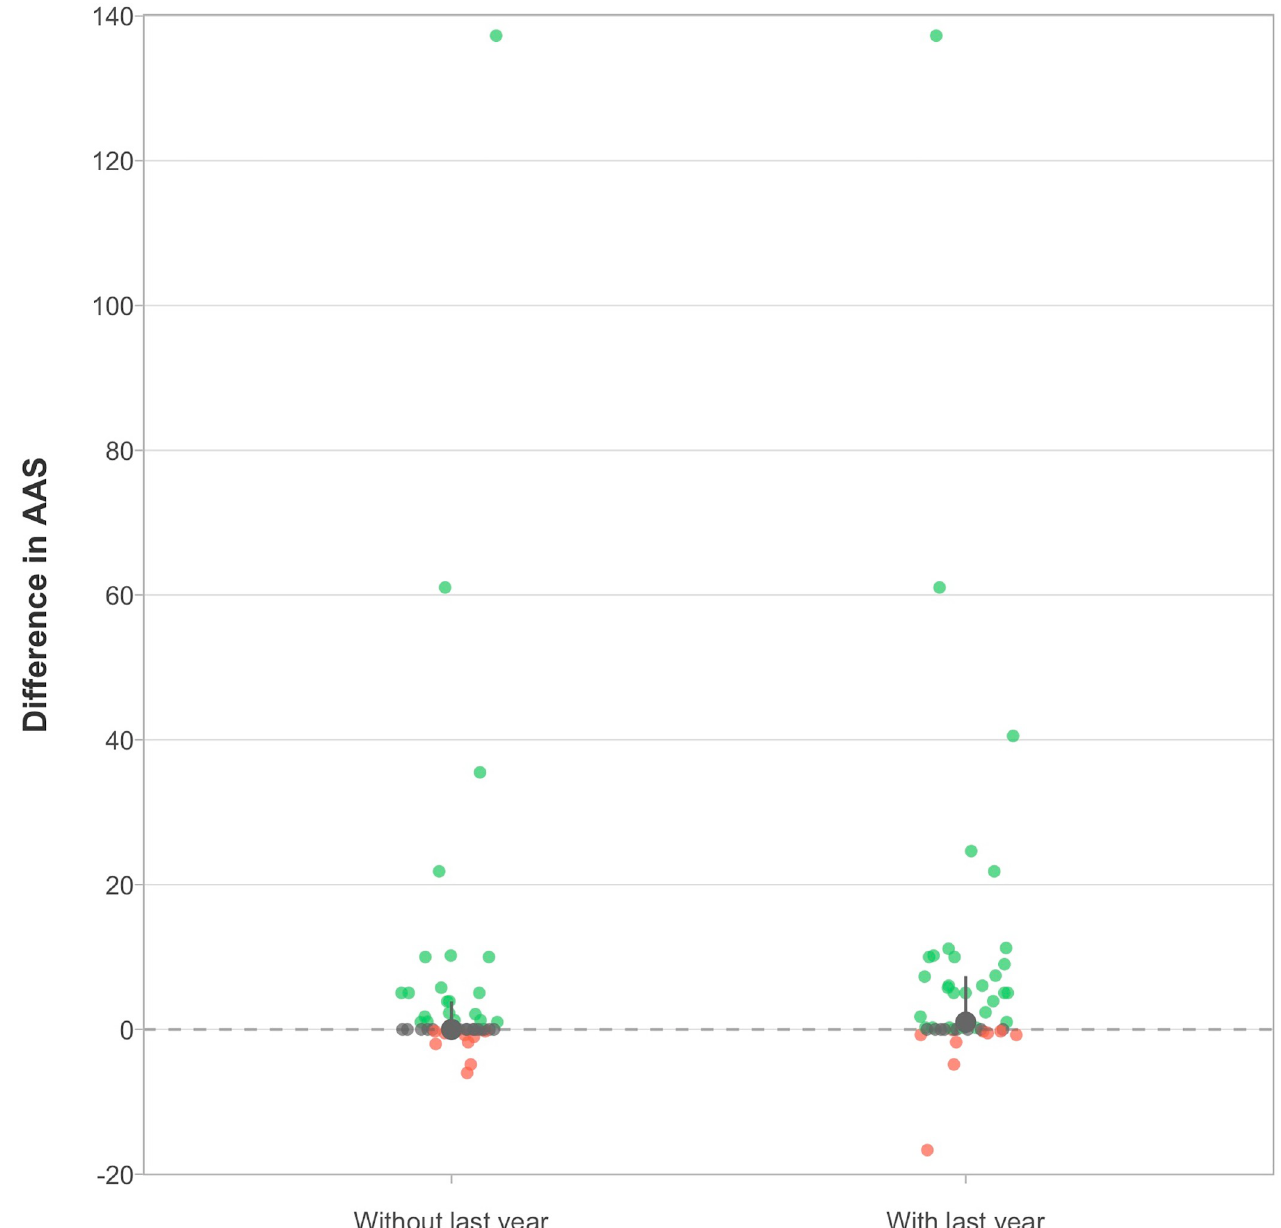
Fig 6. Difference in attention within 47 matched groups of articles retracted within a year of Altmetric data extraction. Each point represents the difference in AAS between the median retracted vs. the median unretracted article within matched groups. Green points represent groups in which the original article received more media and social media attention than matched unretracted articles and red points represent the opposite; points in grey represent no difference between the two. The “With last year” column represents all of the Altmetric attention received, whereas the “Without last year” column represents all Altmetric attention minus the last year. The large point and solid line in grey represent the median and its interquartile range. The median difference between retracted and matched unretracted articles is small (Median, 1) when including attention received over the last year and 0 otherwise. However, substantially more retracted articles received higher attention than matched unretracted articles, regardless of including attention from last year or